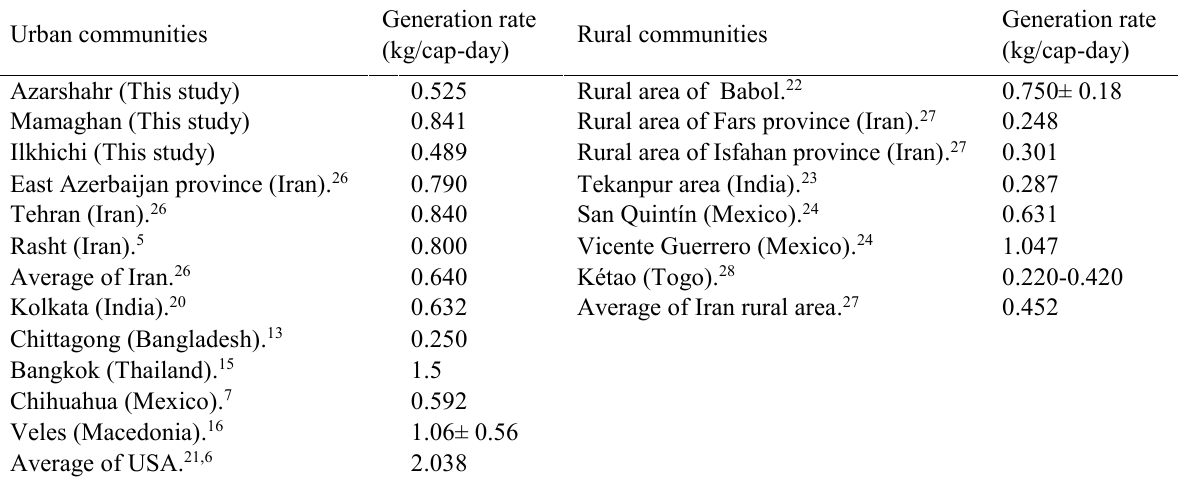
Table 2. The comparison of solid waste generation rates of the studied cities with the other reported researches in urban and rural areas